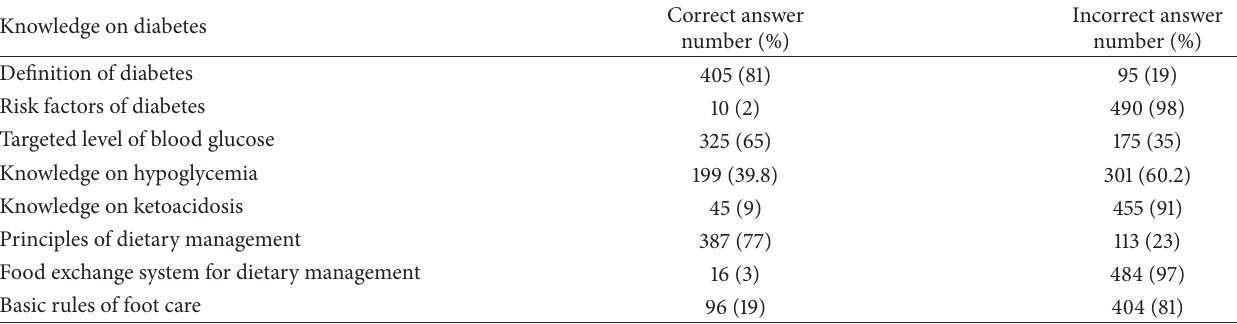
Table 2: Identified deficient knowledge areas relating to DM among patients ( 𝑛 = 500 ).